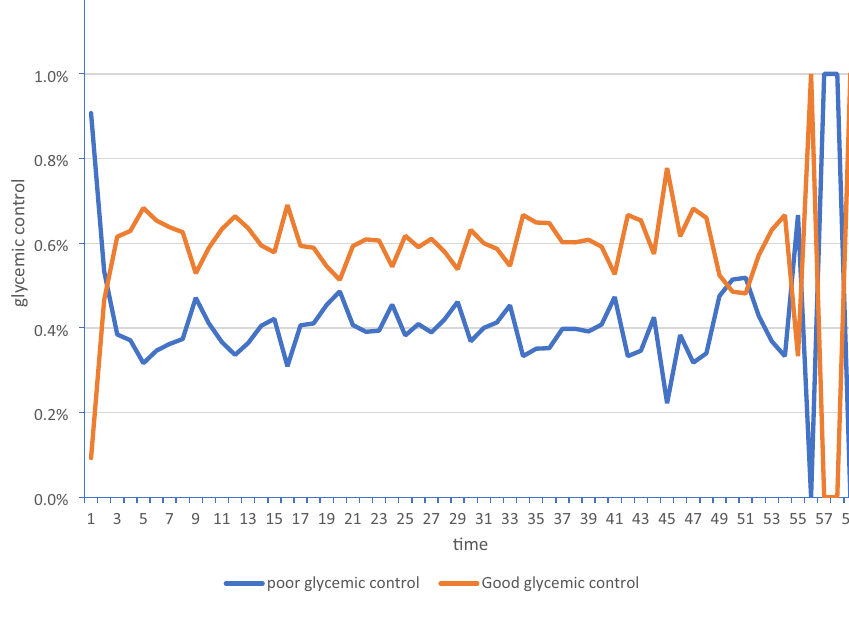
Figure 1. Fluctuation in glycemic control over time among type 2 diabetes patients at Felege Hiwot and Debre Markos Referral Hospital, December 2014–January 2020.